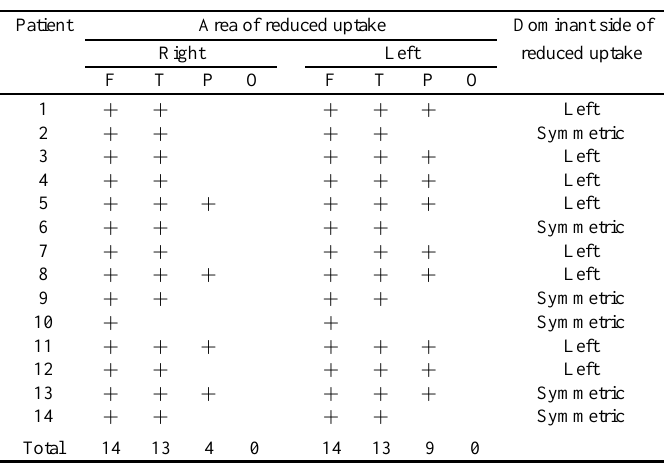
Table 3 Summary of SPECT